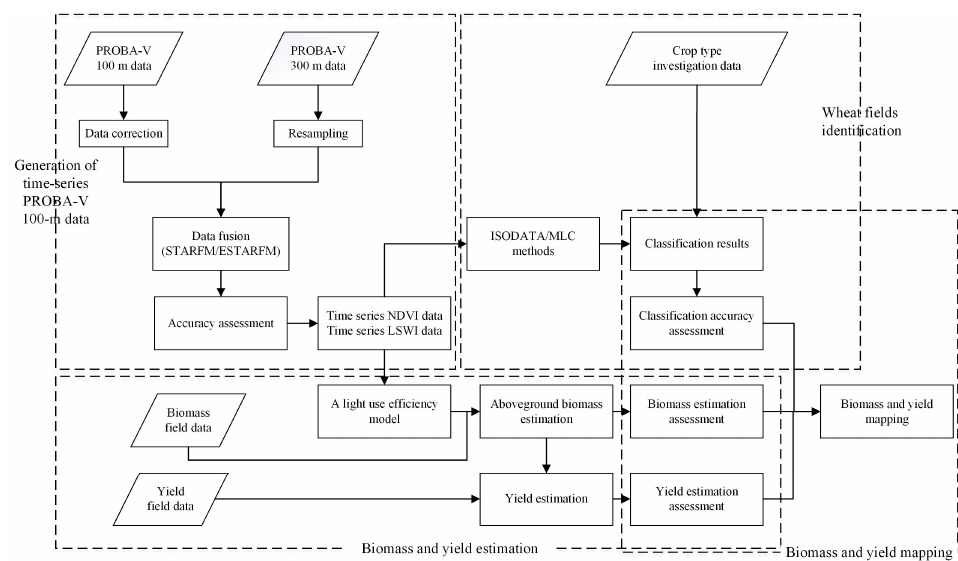
Figure 2. Flowchart of the aboveground biomass and yield mapping process.